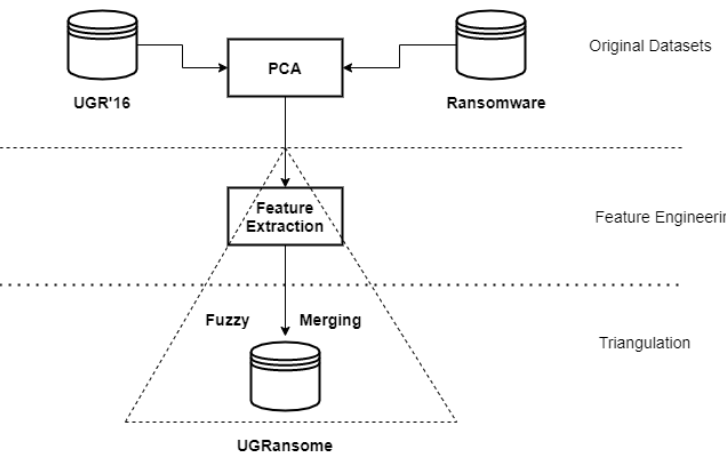
Figure 19. The UGRansome